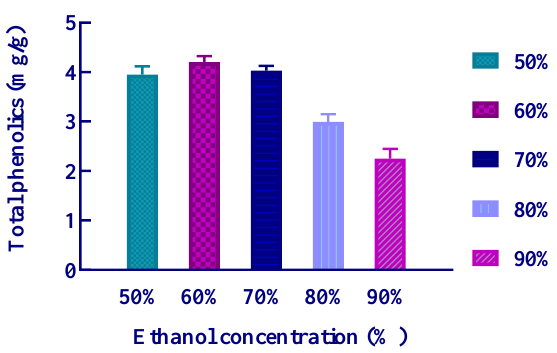
Figure 1. Effect of ethanol concentration on the extraction yield of S. baumii polyphenols. Eight different DES with 40% water content were used to extract S. baumii polyphenols using a solid–liquid ratio of 50 mg/mL, ultrasonic-assisted extraction for 30 min, tempera- ture of 50 °C, and extraction power of 200 W, 40 kHz; 60% ethanol was used as a control. The results are shown in Figure 2. With the exception of the choline chloride and glycerol (DES-3) system, the extraction yield of other combinations of DES was better than that obtained using ethanol. Other combinations of DES led to yields higher than those obtained using ethanol extraction. The choline chloride and malic acid (DES-1) combination for the extraction of polyphenols led to the highest yield of 6.37 mg/g. The extraction yield of choline chloride and malic acid DES was 1.5 times that of 60% ethanol. Therefore, DES can be used to replace organic solvents and show remarkable application potential in the extraction of polyphenols. Based on our findings, DES-1 was selected as the extraction solvent for subsequent experiments.